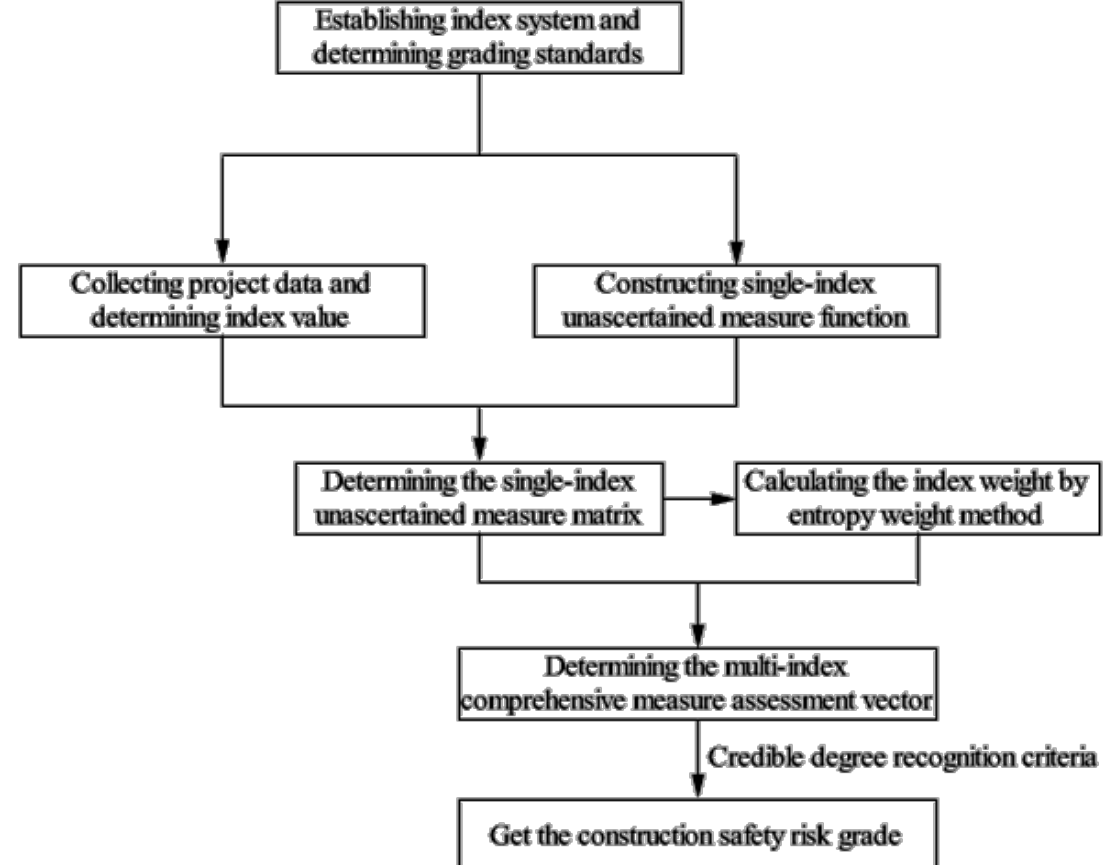
Figure 5. The specific steps of the construction safety risk assessment model.